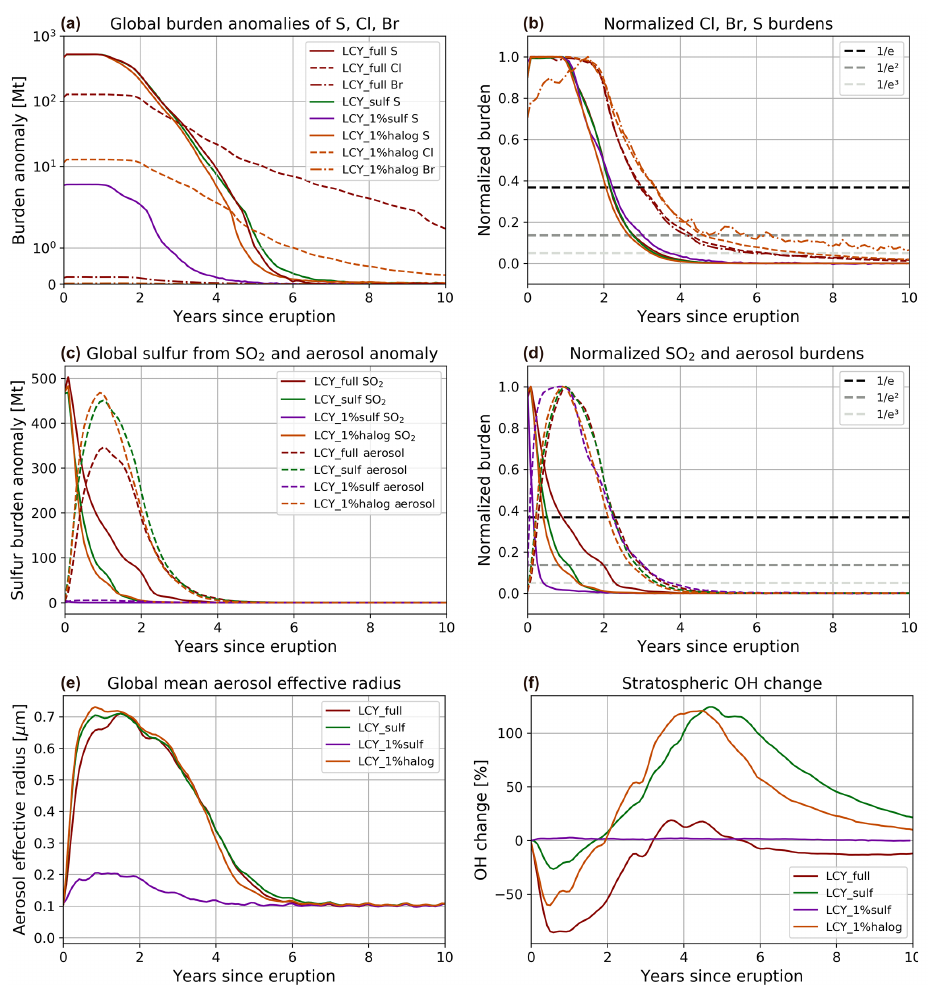
Figure 1. Global evolution of sulfur, halogens, aerosols, and OH for the Los Chocoyos simulations. (a) Total sulfur and halogen burden anomalies. (b) Normalized sulfur and halogen burdens. (c) SO 2 and sulfate aerosols burdens. (d) Same as (b) but for SO 2 and sulfate aerosol burdens. (e) Global mean aerosol effective radius. (f) Time evolution of stratospheric OH change relative to CTR. Dashed horizontal lines in (b) and (d) represent 1 /e , 1 /e 2 and 1 /e 3 .